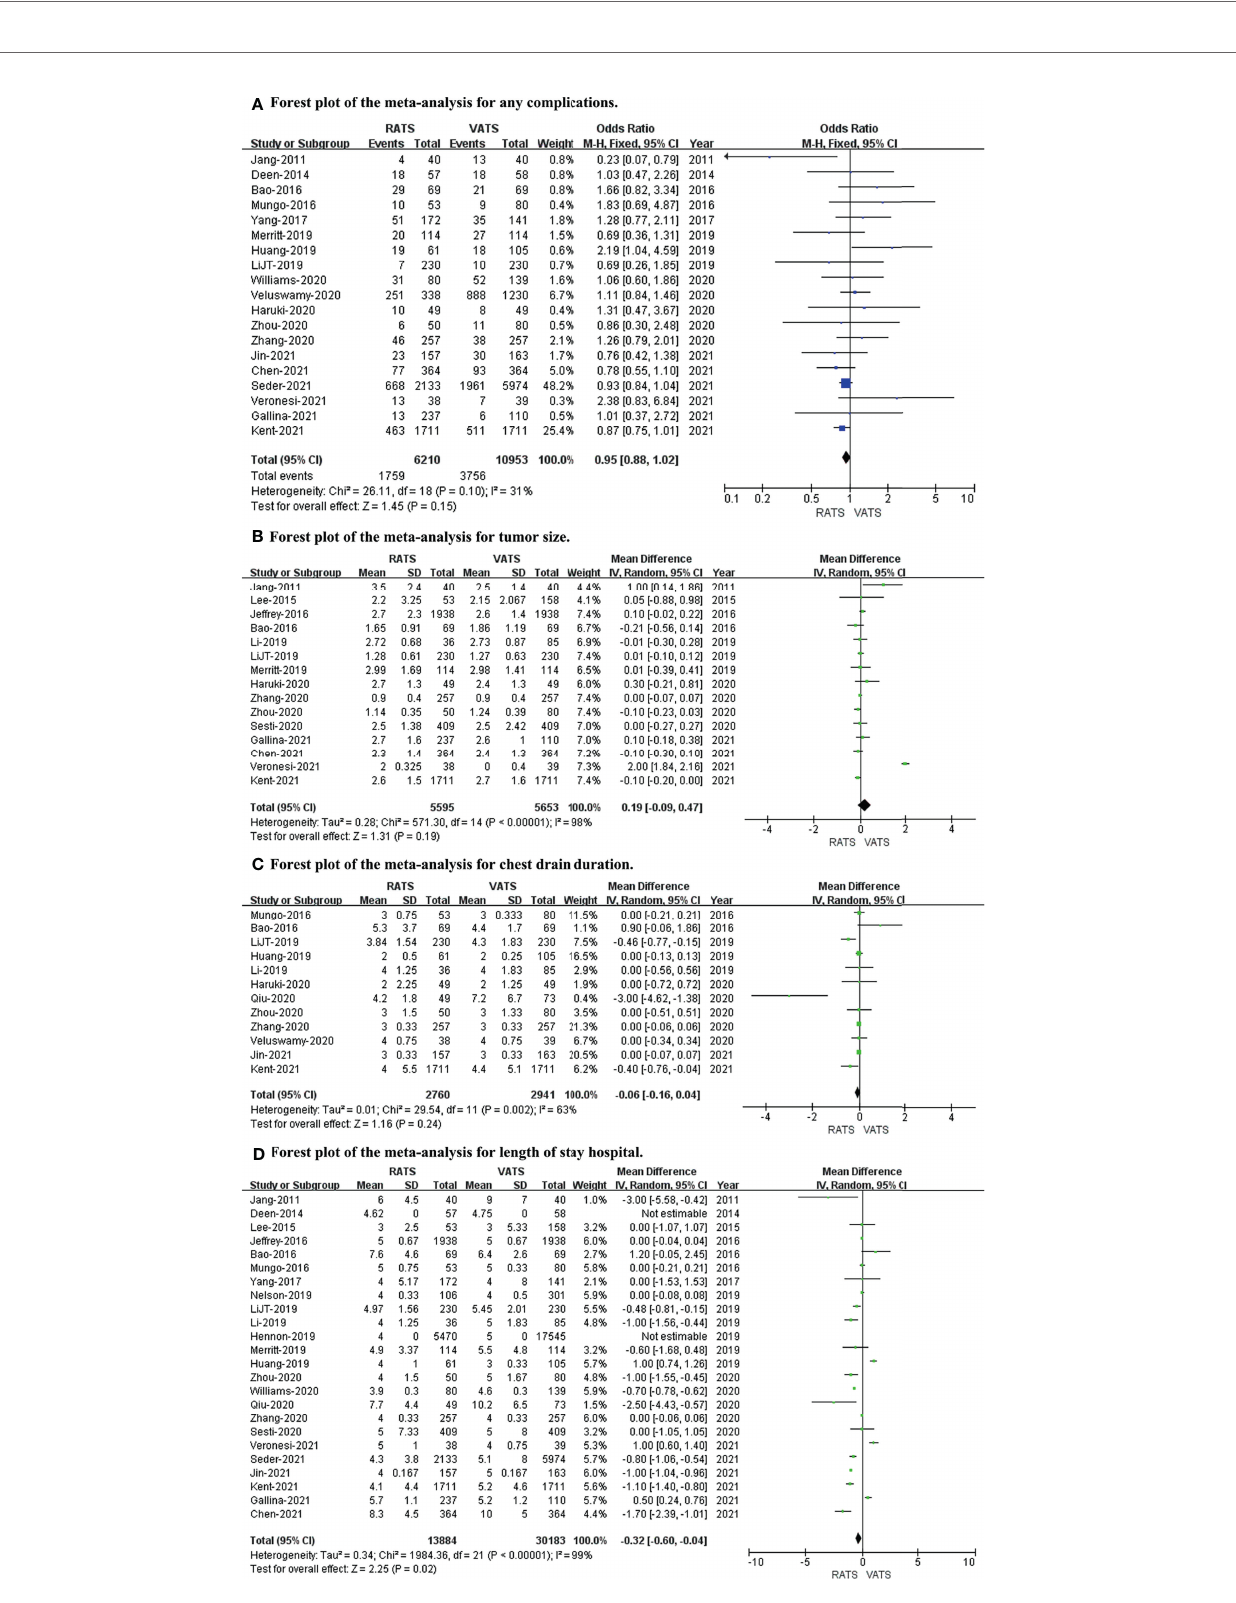
FIGURE 3 | Forest plot of the meta-analysis for postoperative outcomes. (A) Forest plot of the meta-analysis for any complications. (B) Forest plot of the meta- analysis for tumor size. (C) Forest plot of the meta-analysis for chest drain duration. (D) Forest plot of the meta-analysis for length of hospital